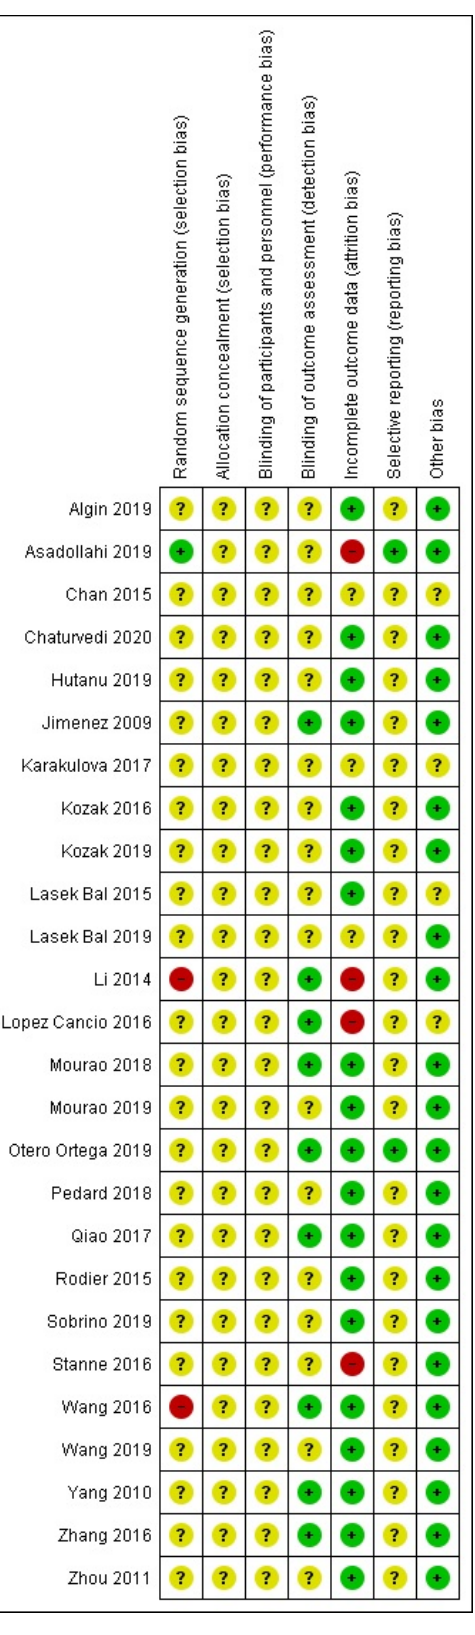
Figure 2. Risk of bias assessment.